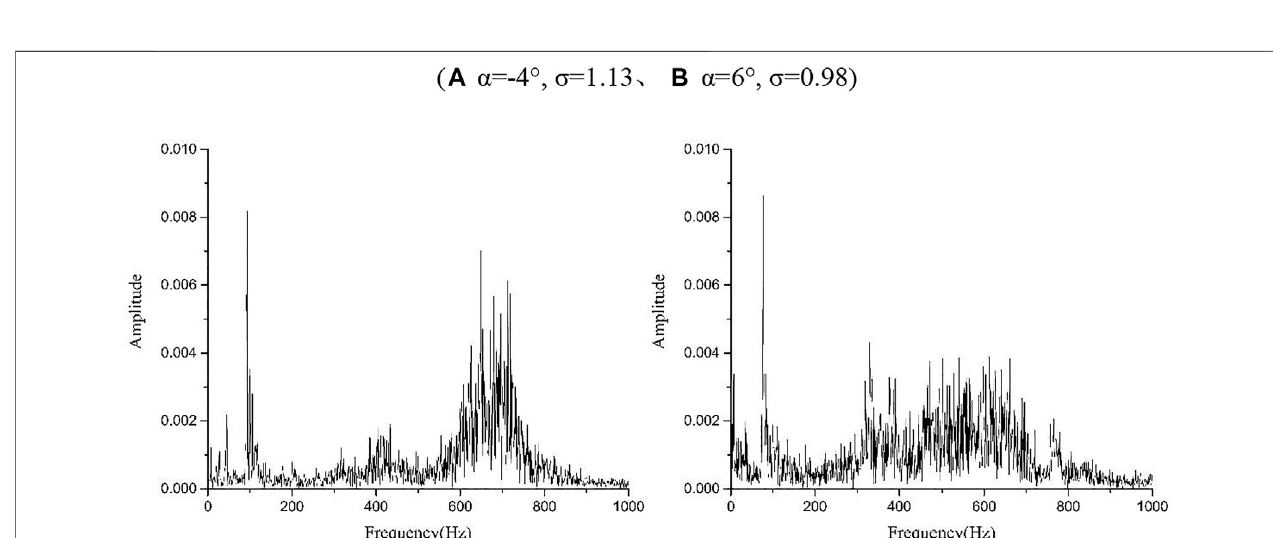
FIGURE 11 | Frequency spectra of the lift signals at cloud cavitation conditions. ( (A) α (cid:1) -4 ° , σ (cid:1) 1.13 、 (B) α (cid:1) 6 ° , σ (cid:1) 0.98)